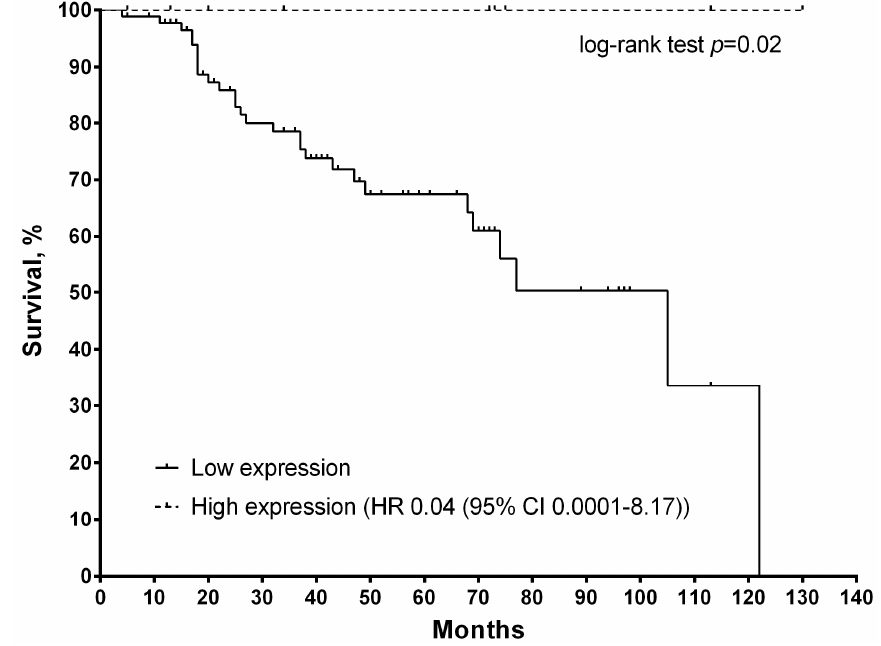
Figure 2. Curves of metastatic survival of breast cancer patients depending on the level of mRNA expression in the surgical material of the GSTP1 gene (log-rank test p = expression in the surgical material of the GSTP1 gene (log-rank test p = 0.02). In the general group of patients with a GSTP1 level of more than 1, the 5-year survival rates were 100% versus 68% in the group with low expression (HR 0.04 (95% CI 0.0001– 8.17); log-rank test p = 0.02).